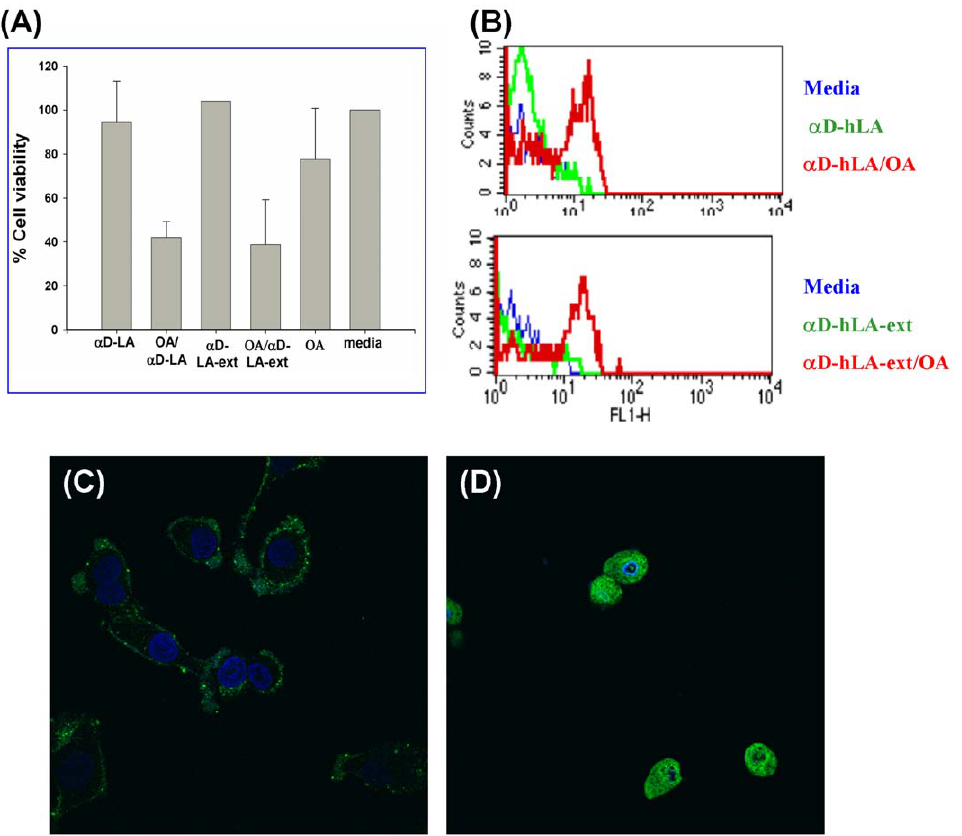
Figure 10. Reduced size HAMLET has comparable properties to complex derived from full-length protein. a D-hLA in complex with OA has biological properties that are similar to mg-hLA OA complex with cancer cell lines SK-BR-3 and MDA-MD-468 (data not shown). a D-hLA and a D- hLA-ext, complexed with OA have comparable tumoricidal activities measured by Trypan Blue (A) and by FACS analysis using Annexin V (B), indicating that the b -domain of hLA is not required for the complex to acquire cytotoxic properties. SK-BR-3 cells were incubated with Alexa Fluor 488 labeled a D-hLA-ext either alone (C) or as OA complex (D) for 3 h. The cells were then fixed with 4% PFA in PBS, and the nuclei were counterstained with Hoechst 33342 (blue). Only a D-hLA-ext-Alexa Fluor 488 (green signal) complexed with OA is internalized by the